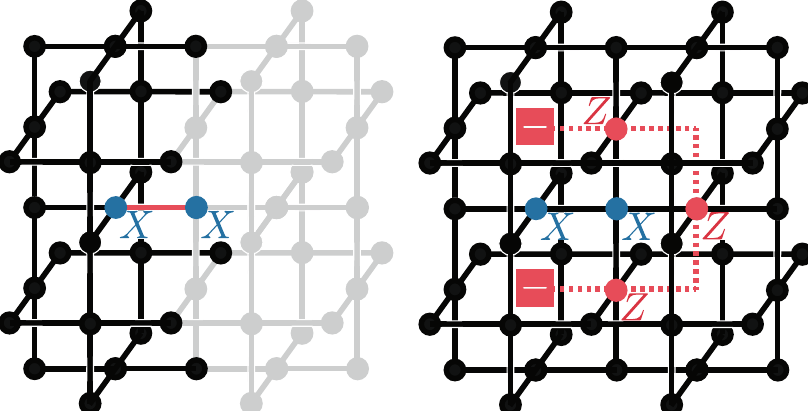
Fig. 8 An example of propagating errors in the RHG cluster state. If an X ⊗ X error occurs after the CZ gate highlighted in red while building the RHG state, subsequent CZ gates spread X errors to Z errors on neighboring qubits. The X ⊗ X error on the CZ gate results in a Pauli error on the fi nal state that involves three Z operators and two X operators. When we measure the qubits in the X basis, the X errors do nothing, while the Z errors result in erroneous measurements on the red highlighted qubits. Overall, the X ⊗ X error results in the error syndrome